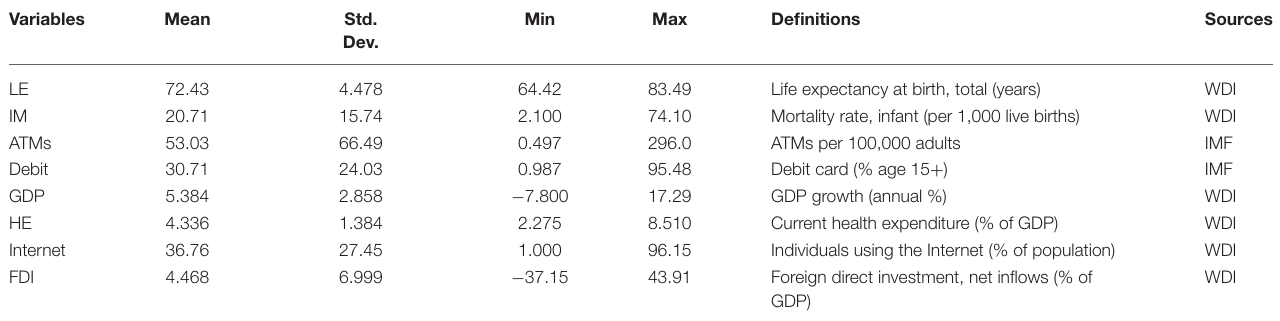
TABLE 1 | Descriptive statistics and data sources.